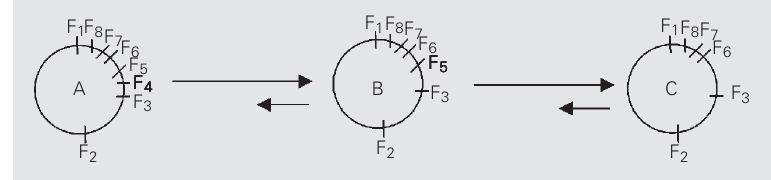
Figure 1. Three mutational patterns revealed by the endonuclease Nhe I showing restriction site gains or losses. The pattern A generates B by loosing F 4 restriction site and B generates C by loosing F 5 restriction